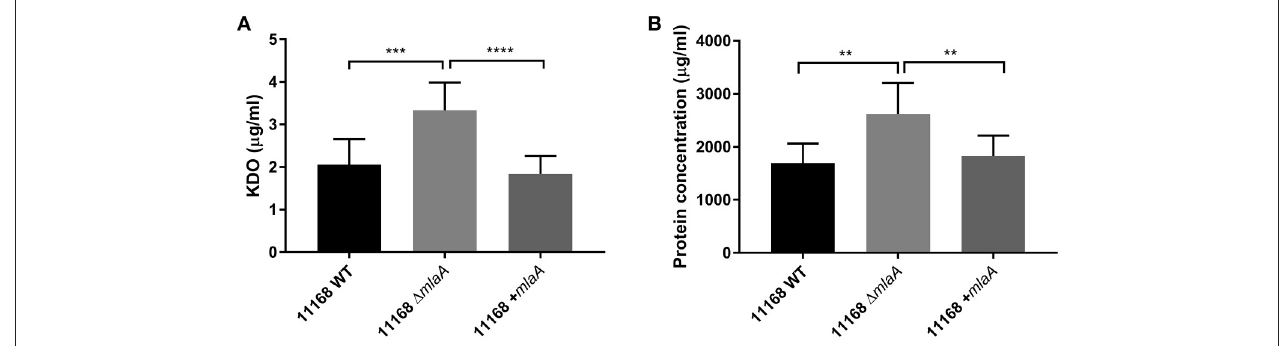
FIGURE 4 | Mutation of mlaA increases OMV production. OMVs were isolated from late-log phase C. jejuni 11168 cultures grown in Brucella broth. OMV preparations from cultures of C. jejuni 11168 wild-type, mlaA mutant, and complement strains of equivalent OD 600 values were quantified by analyzing (A) total KDO as a measurement of LOS and (B) total protein. ** p < 0.01; *** p < 0.001; **** p < 0.0001.